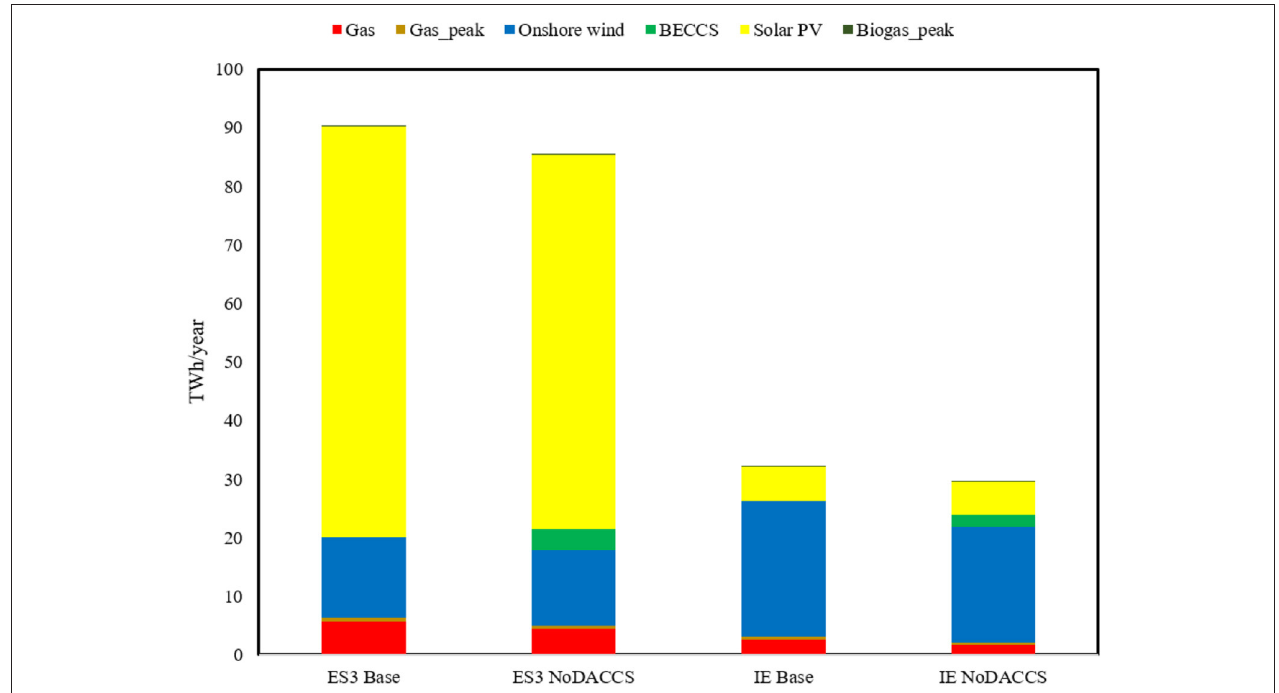
FIGURE 1 | Annual electricity generation in the Base case and in the NoDACCS case in regions ES3 (sunny) and IE